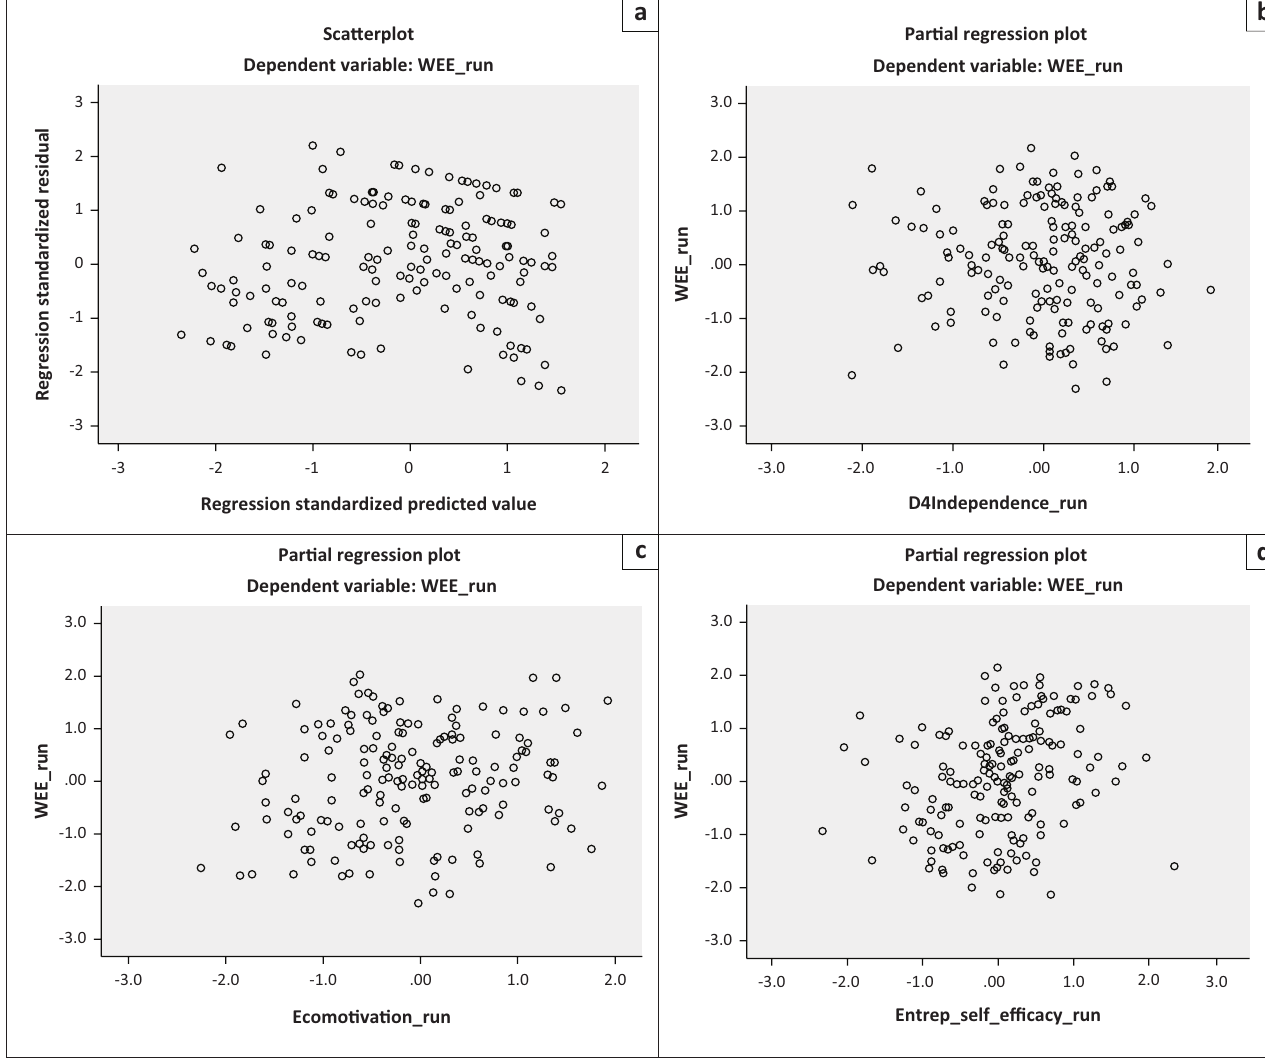
FIGURE 1: Plots of standardised residuals: (a) Normal P-P plot of regression standardised residuals; (b) Partial regression plots on the relationship between desire for independence and willingness to become an entrepreneur; (c) Partial regression plot on the relationship between economic motivation and willingness to become an entrepreneur; (d) Partial regression plot on the relationship between entrepreneurial self-efficacy and willingness to become an